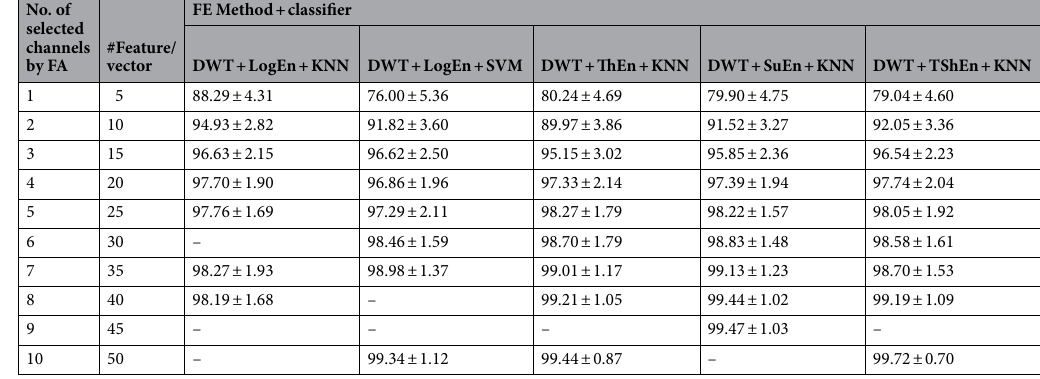
Table 7. The classification accuracy based on subsets with 1–10 channels selected by FA